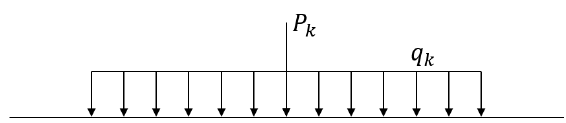
Figure 4. The live-load form applied to each lane.